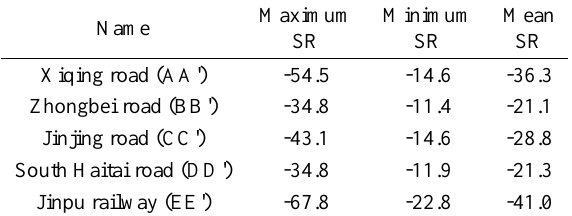
Fig. 5 Profiles of the selected four highways and one railway line Table 3 Maximum, minimum and mean SRs (mm/yr) at the selected highways and railway line